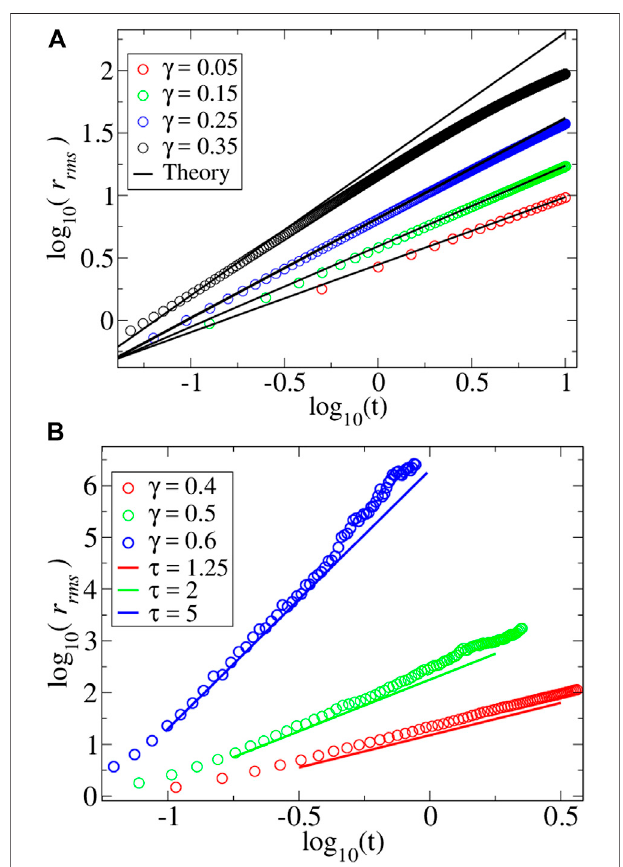
FIGURE 5 | Simulations, sampled at equispaced time intervals (the stapled curve shows the fi rst time) using c (cid:1) 0 . 4 and the fi nite-interaction range model. The curves show p ( y ) (cid:1) C ( r , t ) f 3 ( t ) as a function of y (cid:1) r / f ( t ) compared to theory (red curve) of Eq. 11 and Eq. 12 .